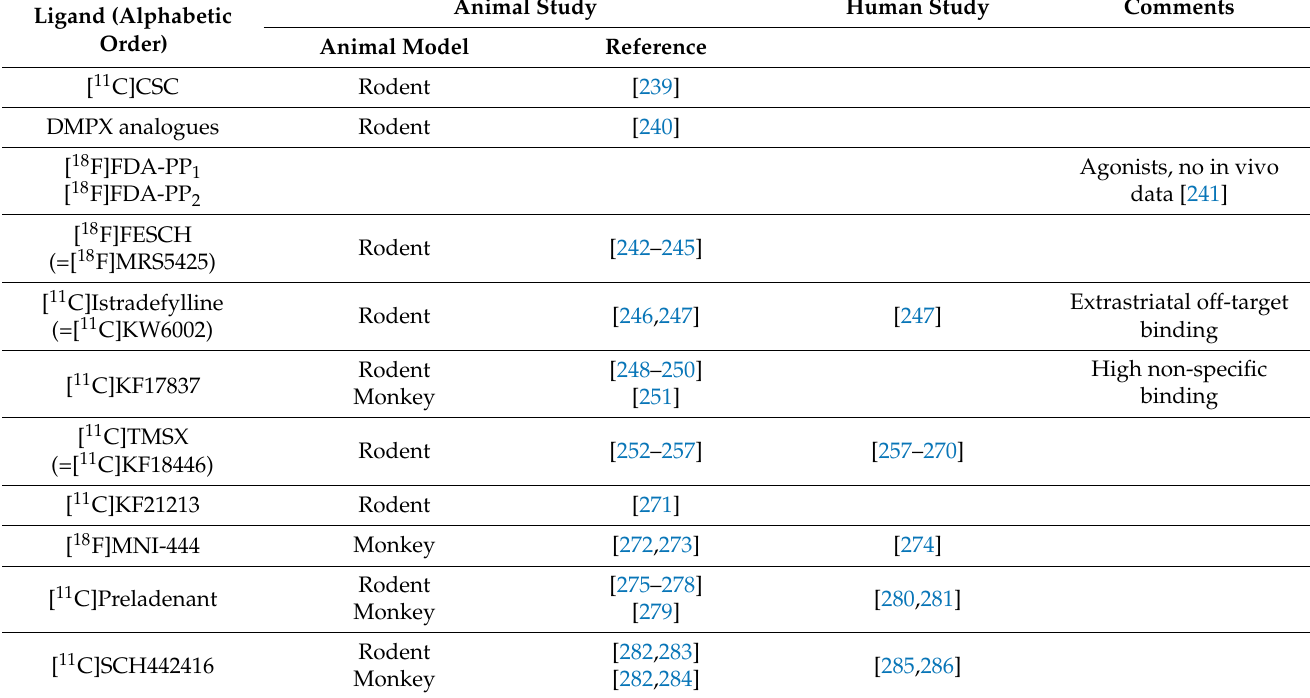
Table 1. Overview of ligands for positron emission tomography (PET) imaging of A 2A receptors. Ligand (Alphabetic